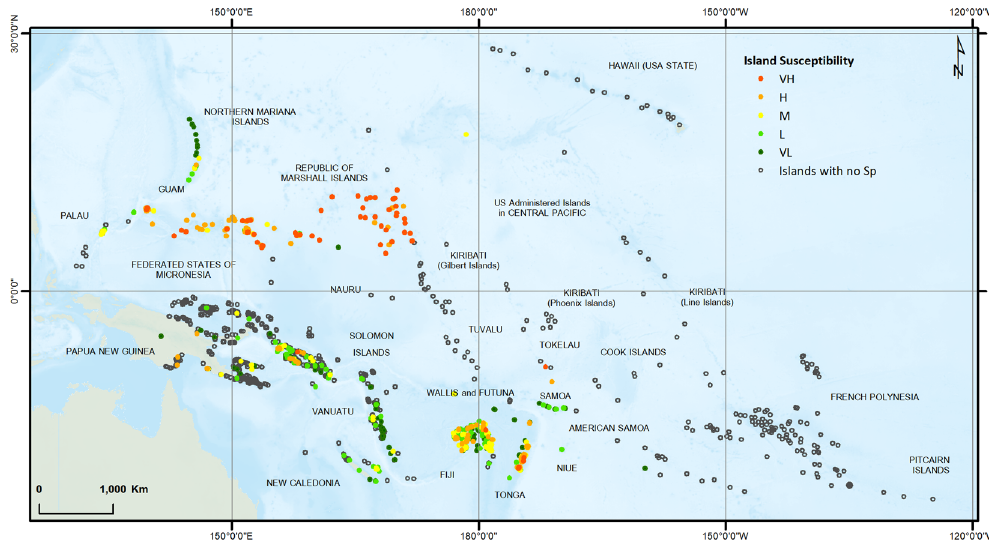
Figure 1. Islands that host at least one vulnerable, endangered or critically endangered terrestrial vertebrate species, with islands susceptibility rankings. (Figure generated using ARCGIS 10.3,